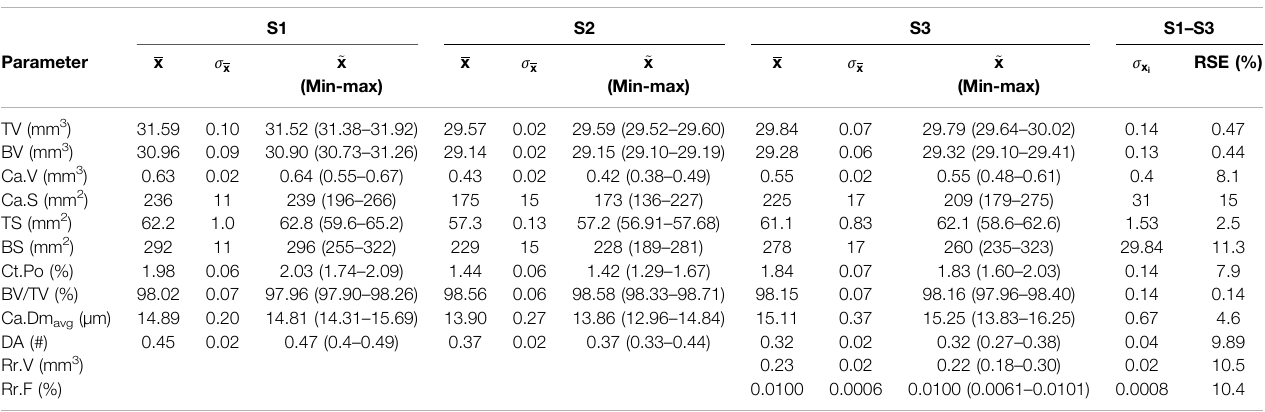
TABLE 5 | Cortical bone parameters of three selected altered samples (S1 – S3) that were repeatedly scanned and analyzed ( n (cid:1) 5). S1 S2